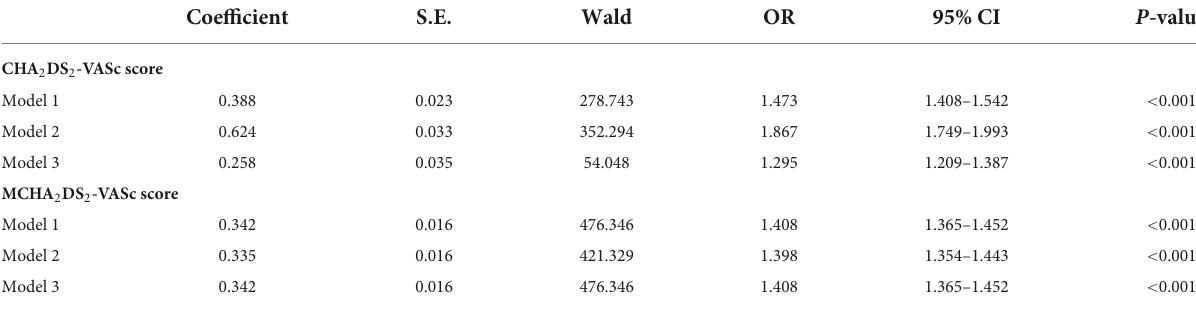
TABLE 3 CHA 2 DS 2 -VASc and MCHA 2 DS 2 -VASc scores in predicting recurrence following myocardial infarction.